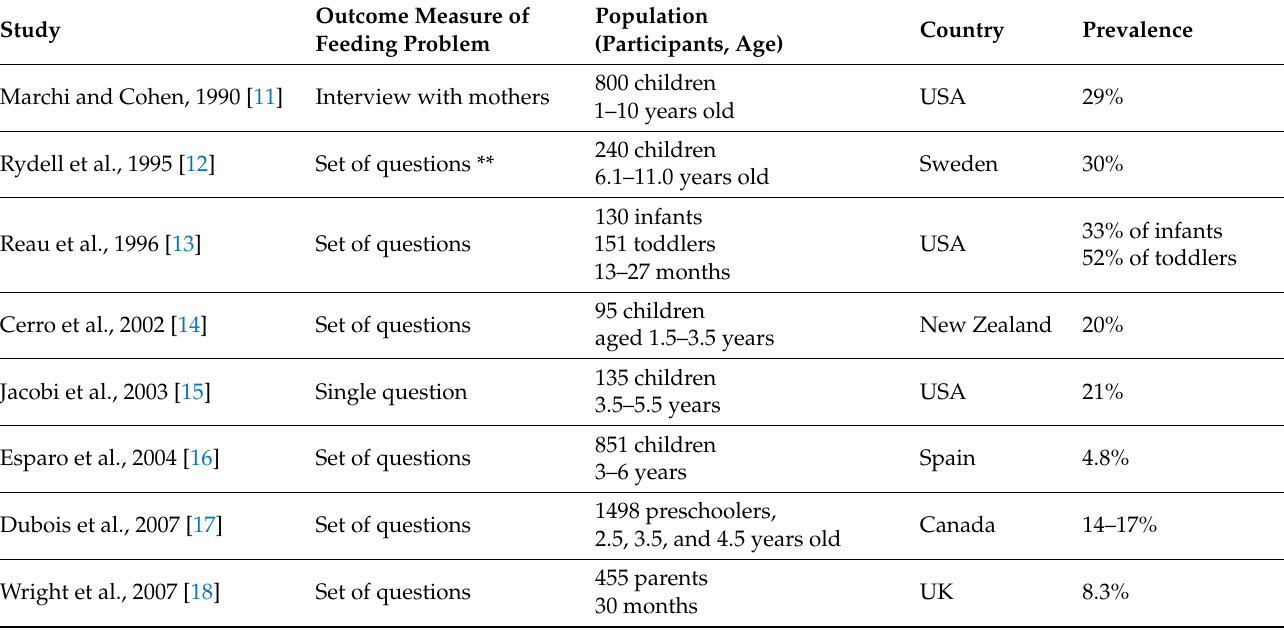
Table 1. Main findings of feeding problem prevalence studies